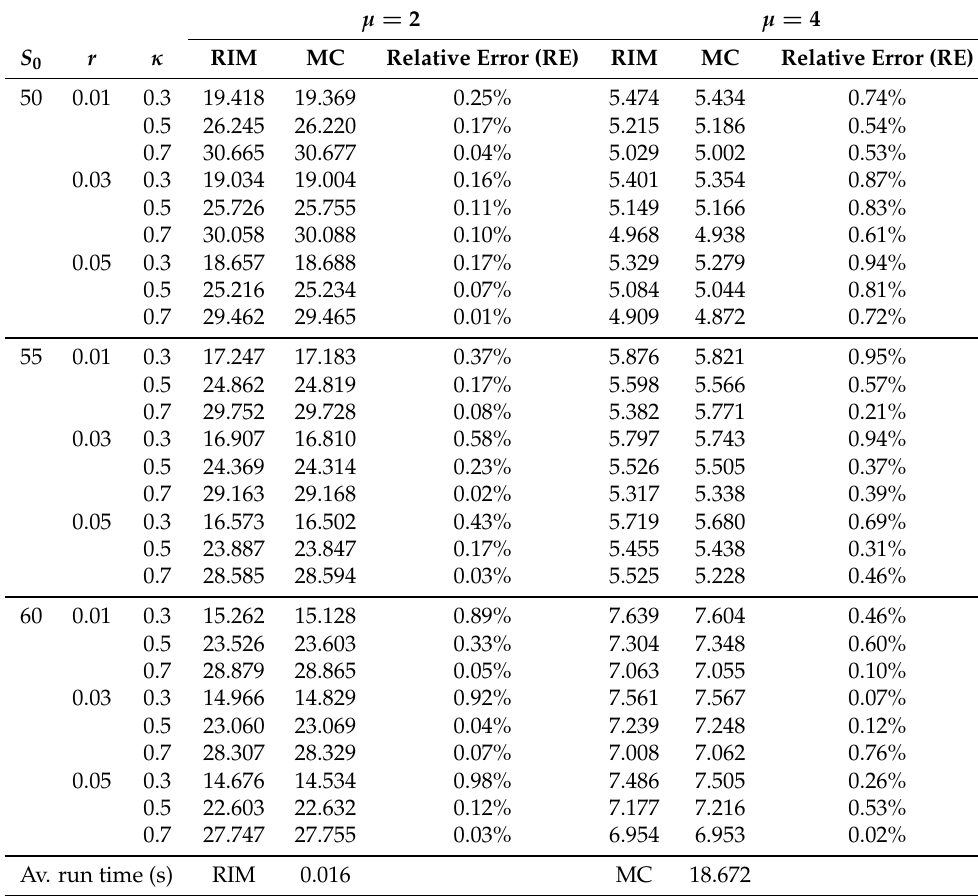
Table 1. Values and CPU times for RIM method and the MC simulation. CPU times are in seconds, and RE is defined by |RIM − MC|/MC ×